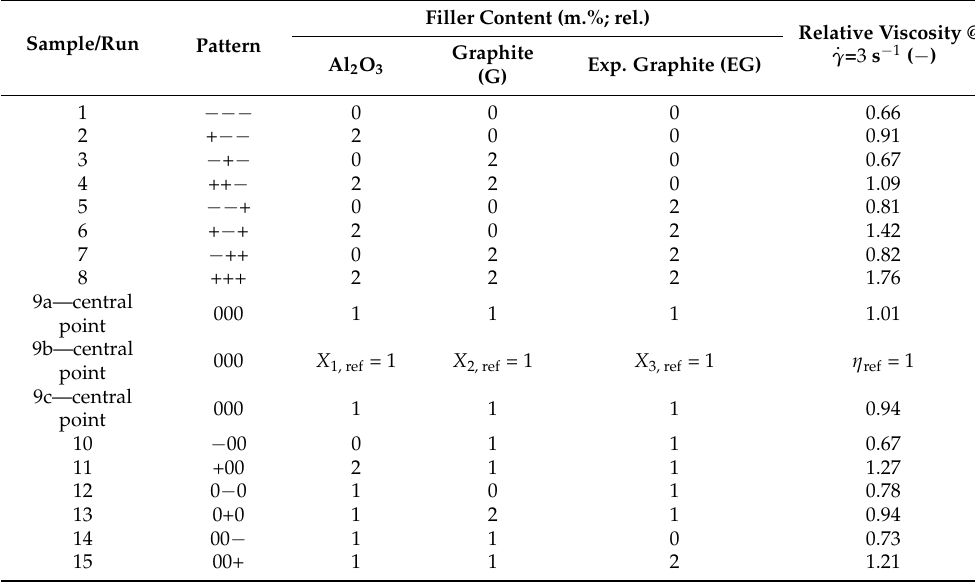
Table 4. Melt viscosity results at a shear rate of 3 s − 1 ; relative data as normalized vs. reference values. Filler Content (m.%; Sample/Run Pattern